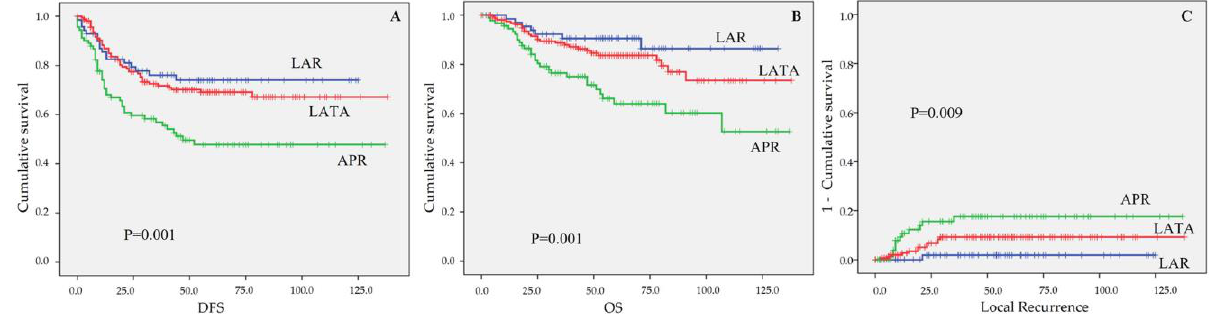
Figure 3. The oncologic outcome according to three operation techniques: ( A ) DFS, ( B ) OS, and ( C ) LR. ( A ) Mean DFS (LAR; 96.41 ± 6.1 months, LATA; 99.87 ± 4.7 months, APR; 74.34 ± 6.7 months) and DFS rate (at 5 years, LAR = 74.1%, LATA = 69.2%, APR = 47.8%, p = 0.001). ( B ) Mean OS (LAR; 119.02 ± 4.7 months, LATA; 114.24 ± 4.2 months, APR; 93.91 ± 6.4 months) and OS rate (at 5 years, LAR = 86.4%, LATA = 83.6%, APR = 64.0%, p = 0.001). ( C ) LR rate (at 3 years, LAR = 1.9%, LATA = 9.2%, APR = 17.6%, p = 0.009). DFS, disease-free survival; OS, overall survival; LR, local recurrence; LAR, low anterior resection; LATA, laparoscopic abdominal transanal proctosigmoidocolectomy with coloanal anastomosis; APR, abdominoperineal resection. Table 6. The results of oncologic outcomes according to significant factors through the multivariate Cox regression anal- ysis.